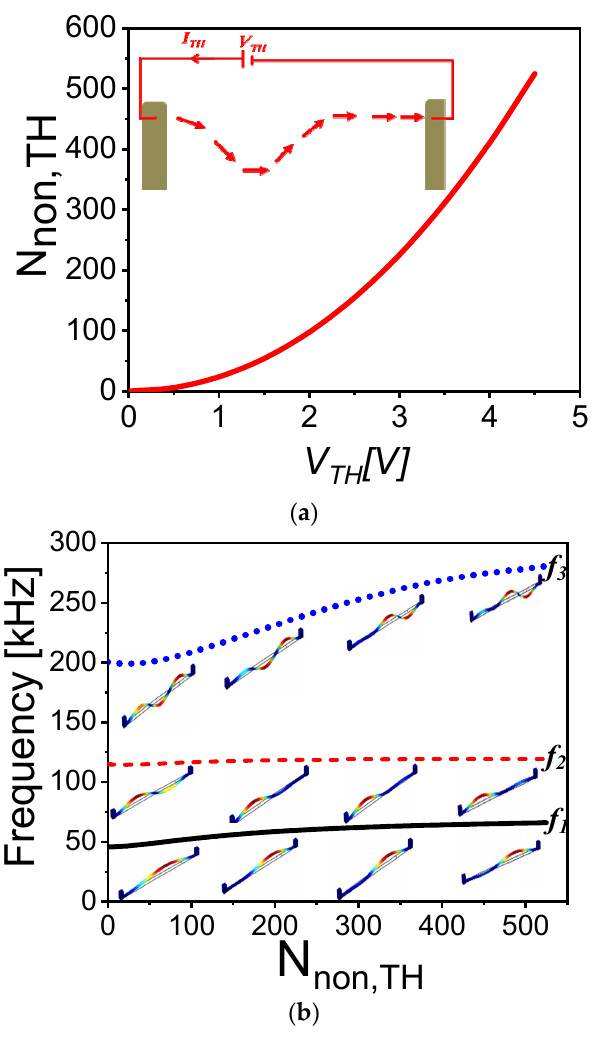
Figure 9. ( a ) Variation of the nondimensional axial stress with the applied electrothermal voltage. The inset in ( a ) presents the schematic of the electrothermally tuned hybrid resonator. ( b ) The variation of the three lowest natural frequencies with nondimensional axial load for dome length equal to 0.8 L hb and initial rise equal to 2 μ m. The insets in ( b ) present the mode shapes of the corresponding frequencies at different axial load (i.e., different V TH ).